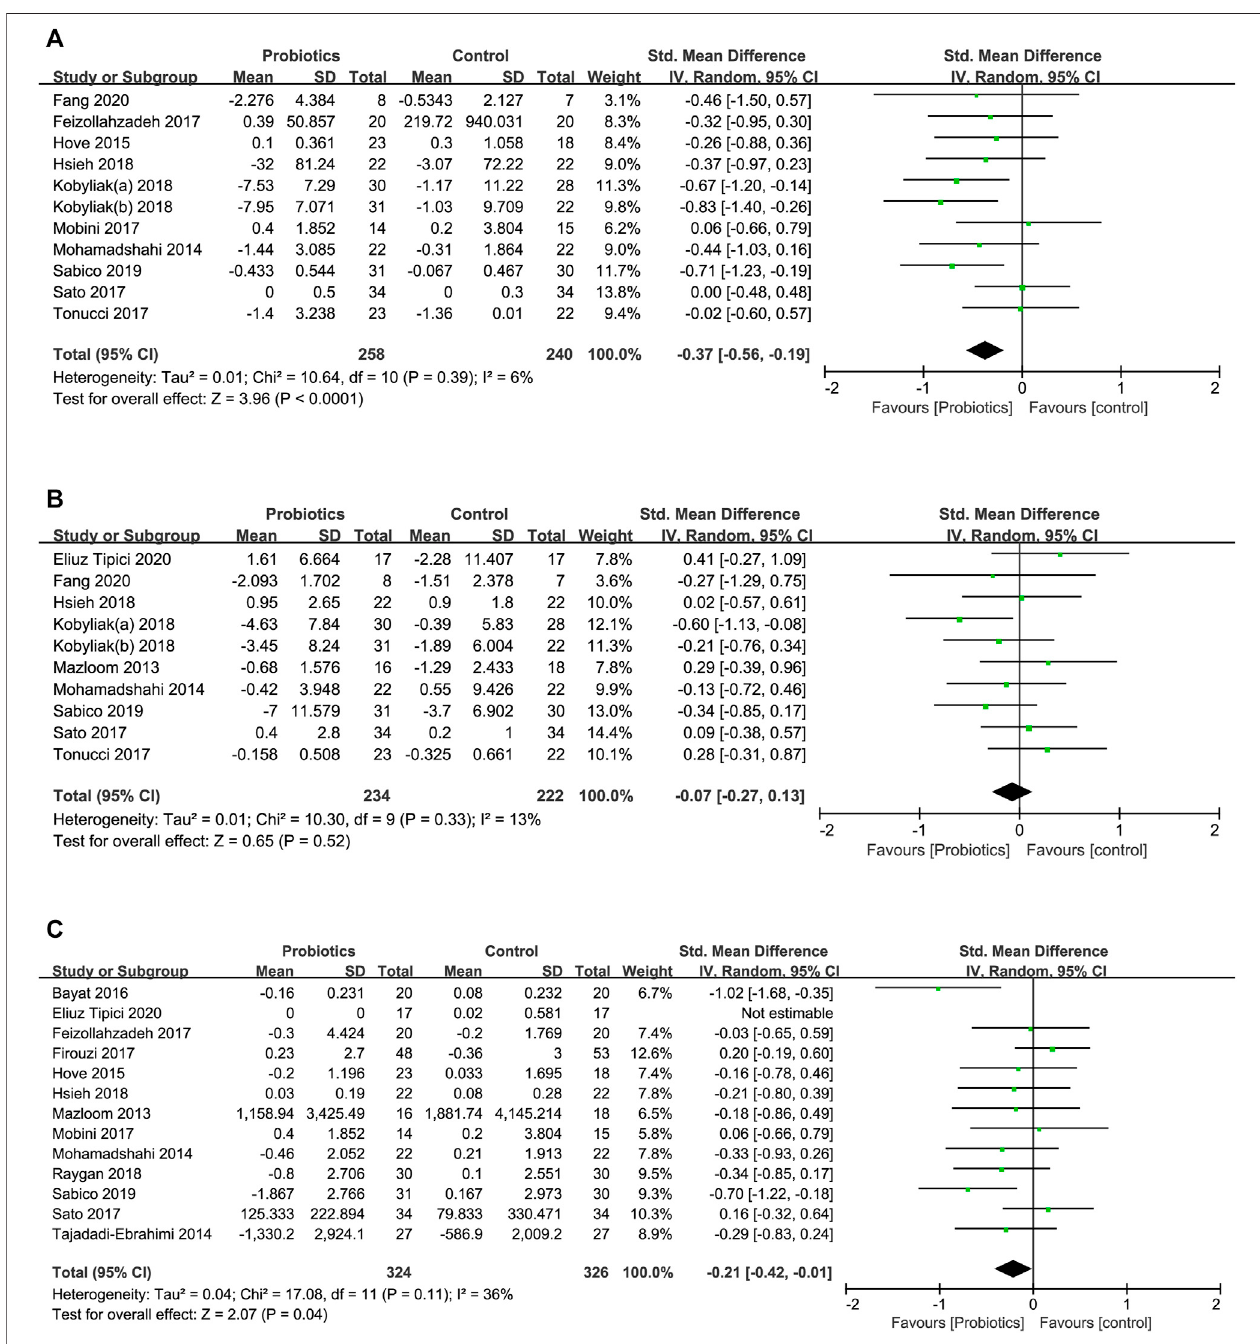
FIGURE 4 | Forest plots of the effects of probiotics on (A) TNF- α , (B) IL-6, (C) CRP.